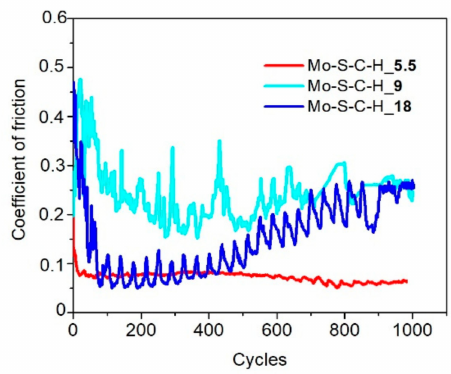
Figure 12. Characteristic evolution of the friction coe ffi cient as a function of the cycle number for the Mo-S-C-H thin-film coatings obtained by reactive PLD at the pressures of H 2 S gas of 5.5, 9, and 18 Pa. Pin-on-disk tribometer testing was conducted in dry friction conditions at − 100 ◦ C.